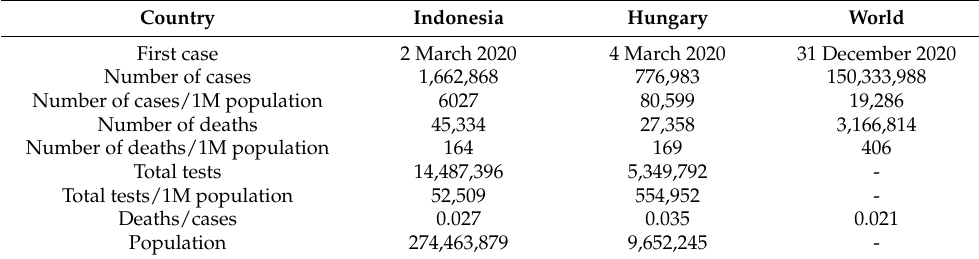
Table 1. COVID-19 Reported Cases, Deaths, and Test in Indonesia, Hungary and the World. Country